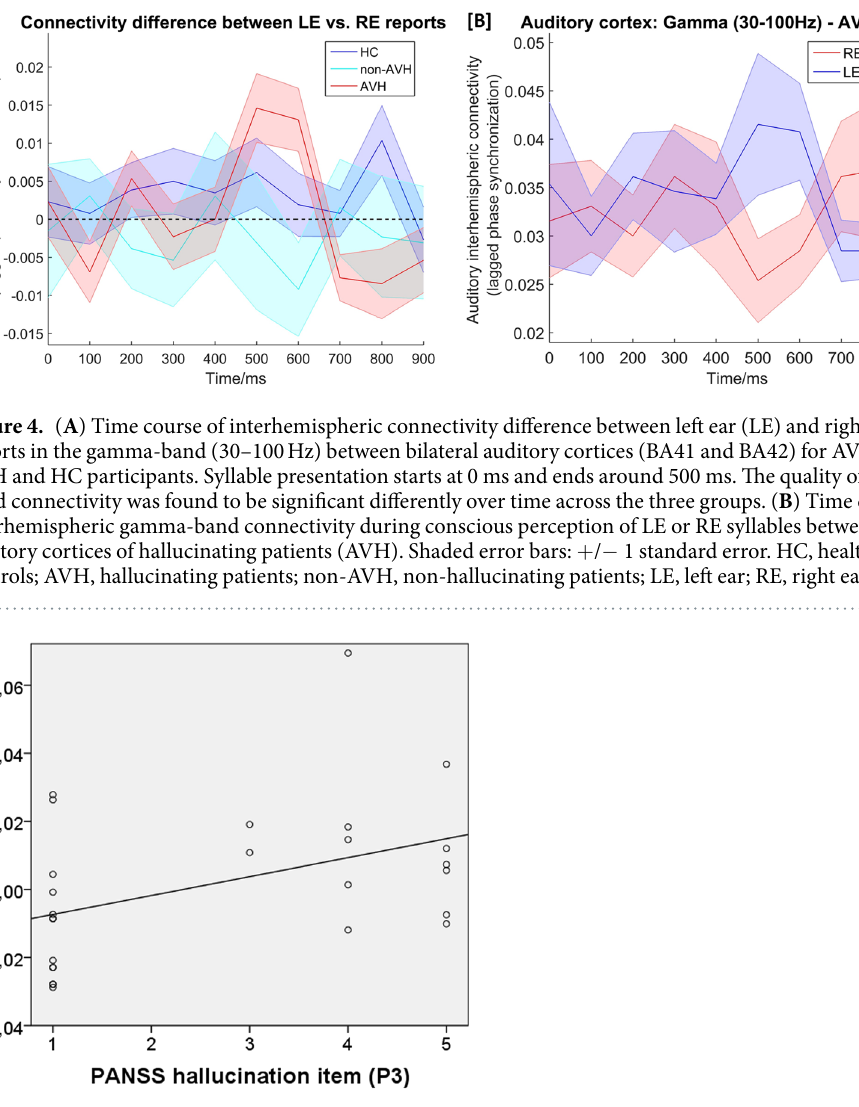
Figure 5. Spearman’s correlations between PANSS hallucination item (P3) and gamma-band synchrony (LPS) between left and right auditory